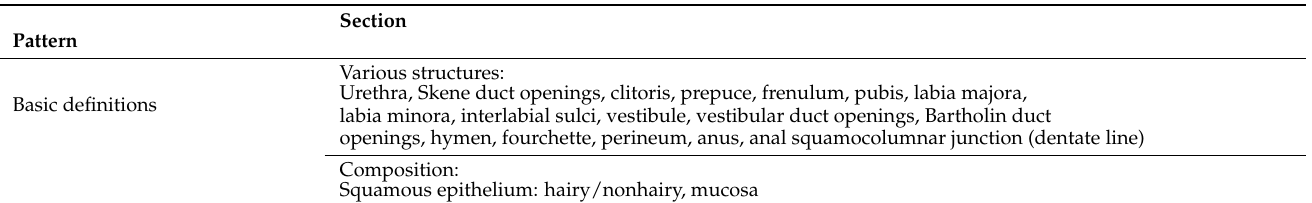
Table 1. The 2011 IFCPC clinical/colposcopic terminology of the vulva (including the anus) *. Section